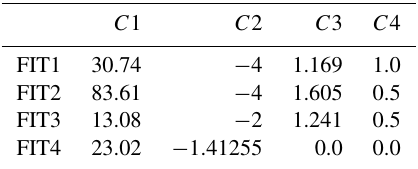
Table 4. Four groups of fitting parameters (FIT1, FIT2, FIT3, and FIT4) for Eq.